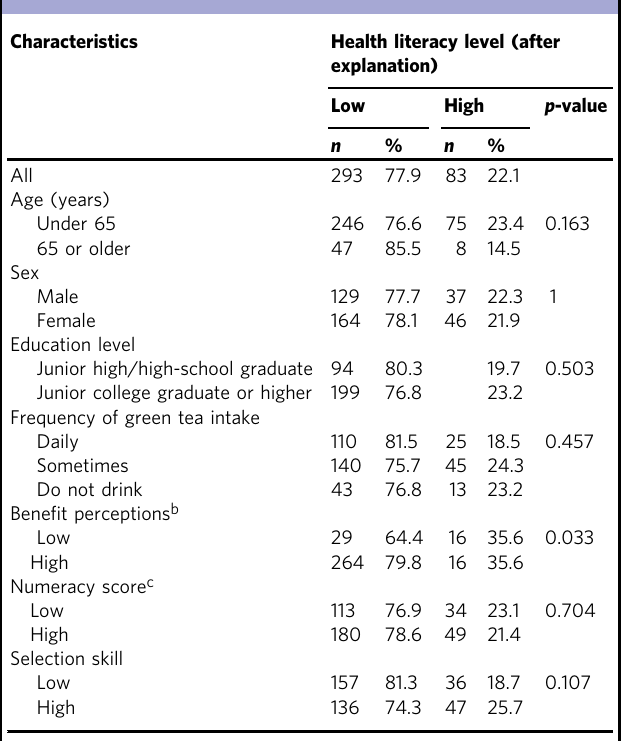
Table 3 Usefulness of the developed con fi rmation scheme for identifying unreliable COVID-19-related health information ( N = 376) a